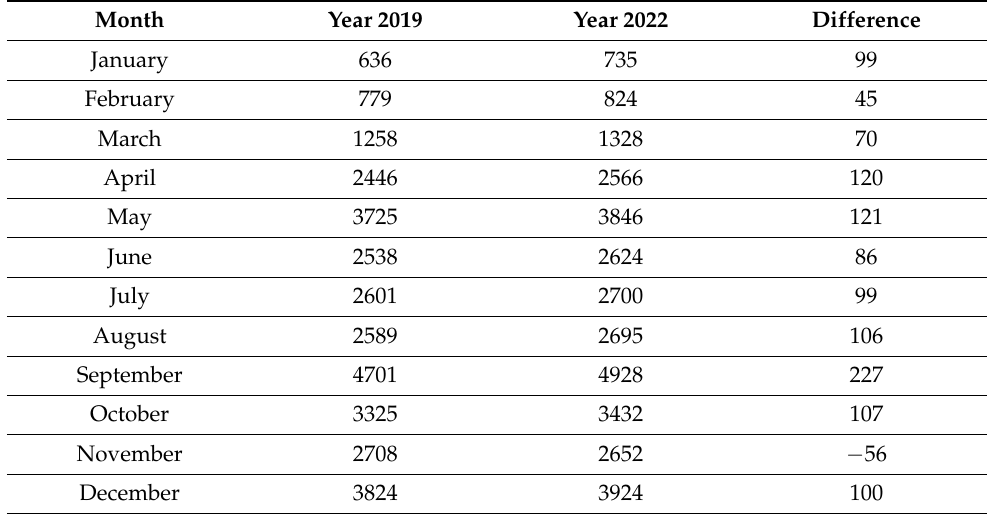
Table 6. Predictions of enotourism demand for the Montilla-Moriles